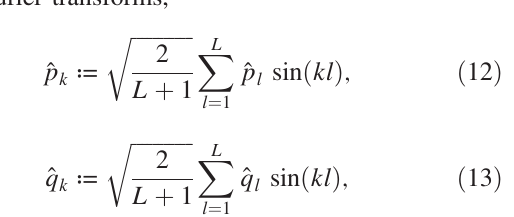
particles accumulate at the right (left) edge of the system for γ > 0 ( γ < 0 ) [Fig. 2(b)]. Such localization of an extensive